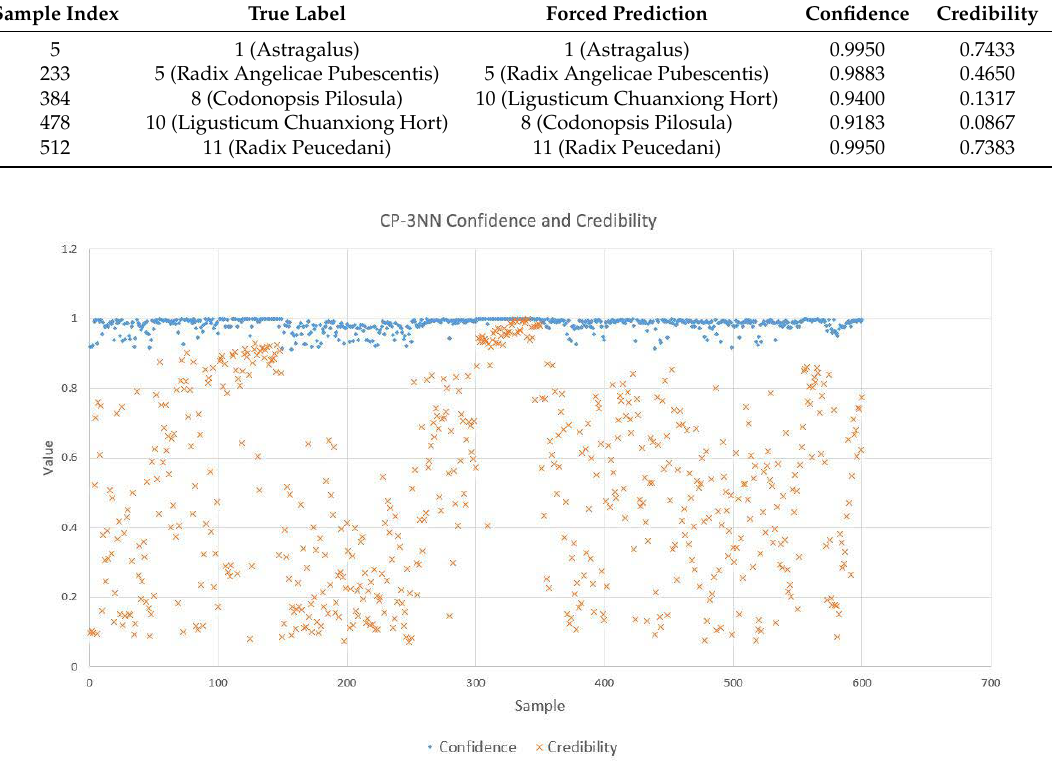
Figure 8. Confidence and credibility for 12 herbal medicine classifications with